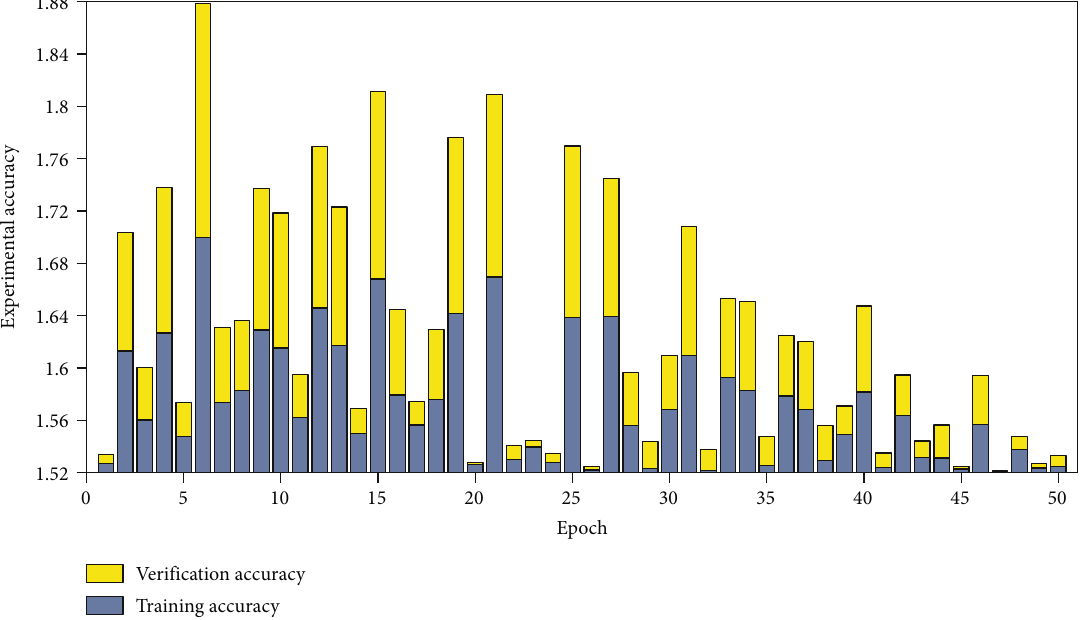
Figure 5: Accuracy map of capital letter images in English self-learning.